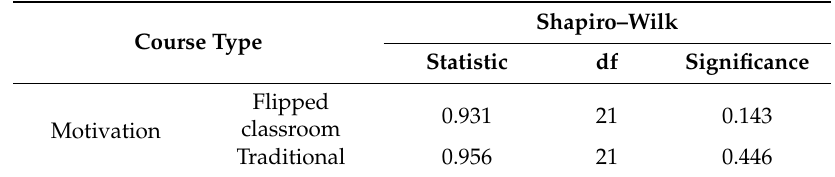
Table 1. Student motivation—Shapiro–Wilk test results.